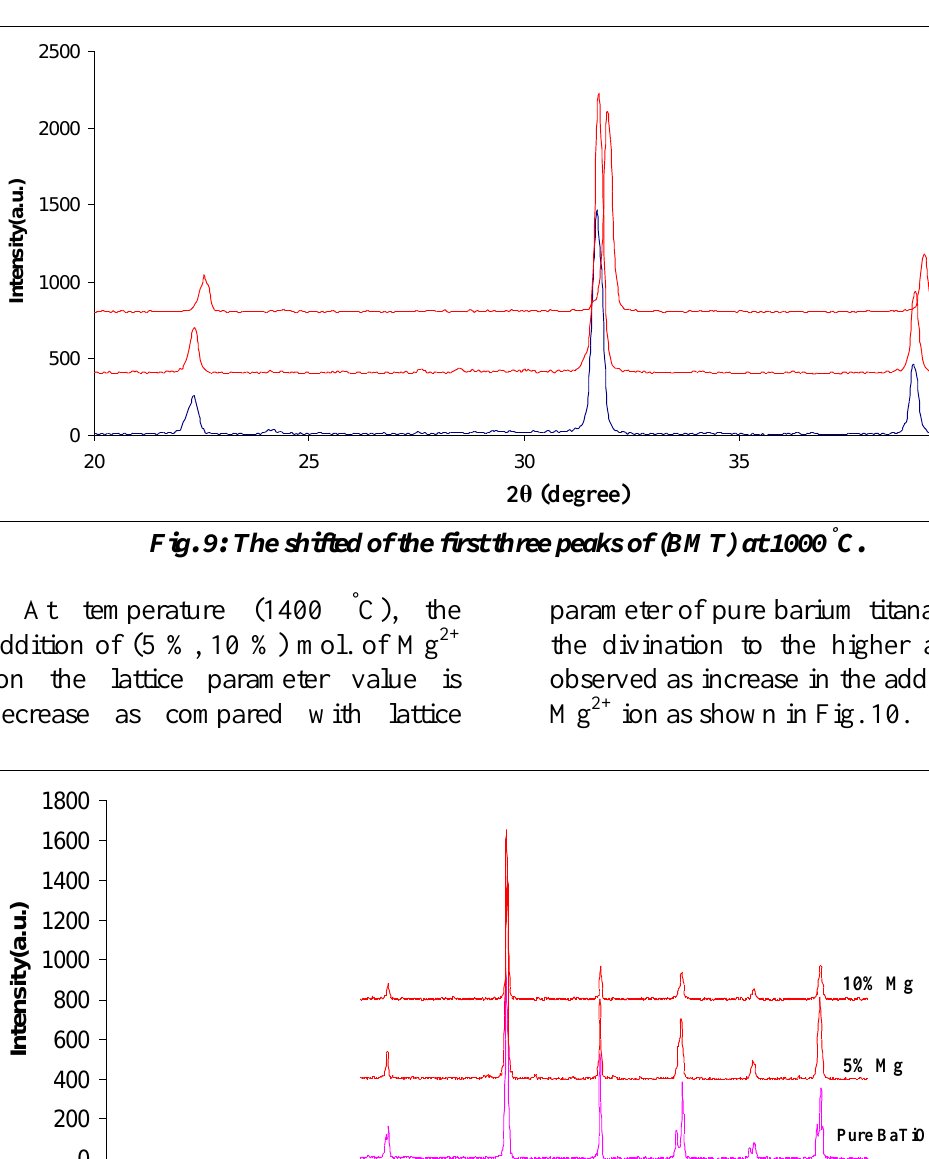
with additives MgCO 3